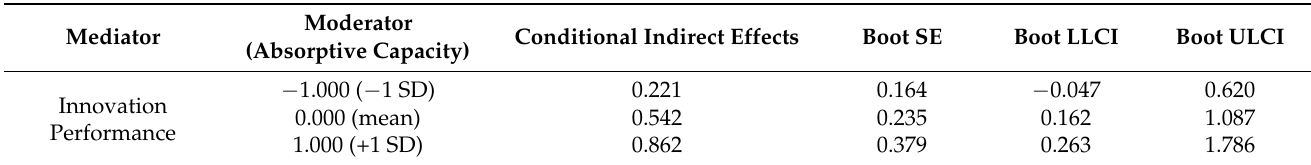
Table 4. Bootstrap significance test for the conditional indirect effect of knowledge acquisition on sales growth through innovation performance at different levels of absorptive capacity.